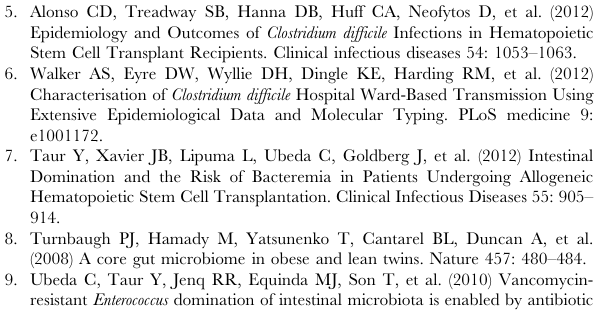
Figure S1 Incidence of Clostridium difficile infection within observation period, in entire study cohort (biospecimen + observa- tional group, N= 1238). Expressed as percentage of transplant recipients. (TIFF) Figure S2 Intestinal composition of C. difficile in the biospeci- men group (N = 94). Fecal specimens are barplotted over transplant day. The timing of C. difficile testing and antibiotic administration is shown at the top of each plot. (TIF) Table S1 Characteristics of Patients, Observational Group (N = 1144). Table S2 Multivariate predictors of CDI in biospecimen group (N = 94). Table S3 Multivariate predictors of CDI in observational group (N = 1144). Table S4 Predictors of toxigenic Clostridium difficile colonization, by fecal detection of tcdB (N = 94).